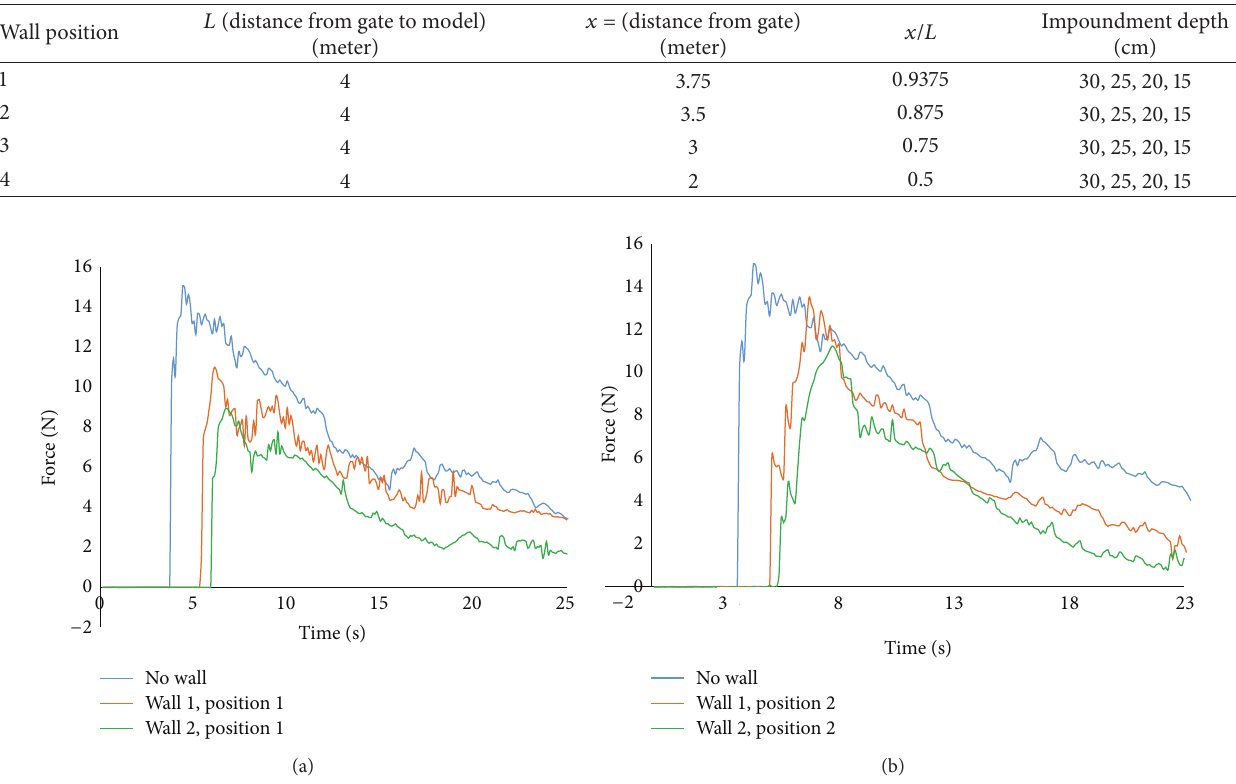
Table 1: Wall positions with corresponding impoundment depth.